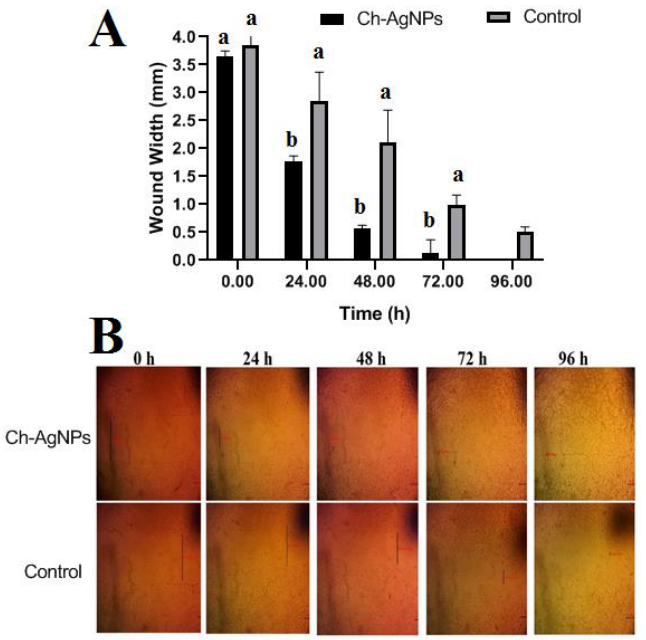
Figure 9. ( A ) Effects of different treatments on the wound area contraction (0 – 96 h). Values are given as mean ± SD ( n = 3/group). Different letters indicate significant differences ( p < 0.05). ( B ) Representative phase contrast micrographs of cells treated with 100 μg/mL Chi/Ag-NPs at 0 and 24 h. Wound closure rates are expressed as percentage of scratch closure from after 0 to 96 h compared to initial area. Red and black lines mean center and wide of the wound.